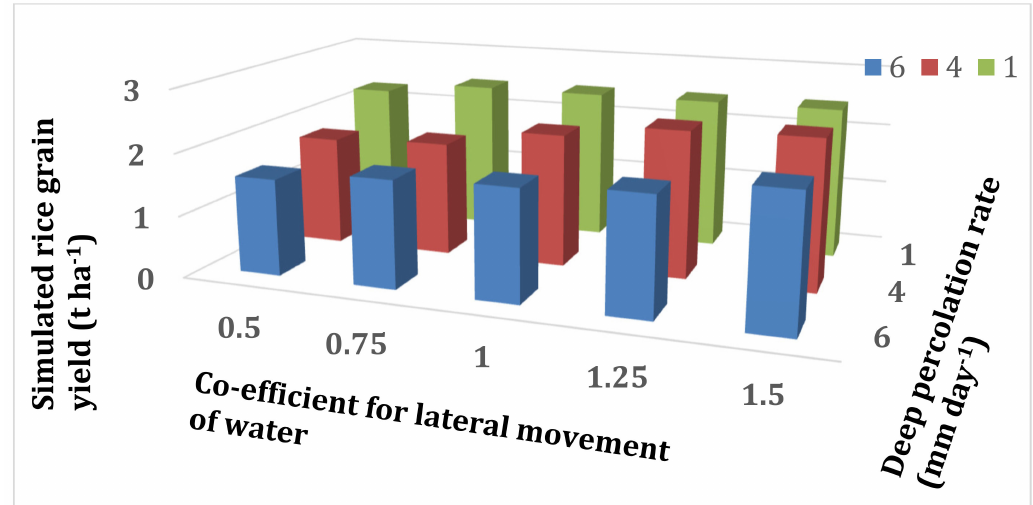
Figure 6. Simulated grain yield (t ha -1 ) for rice cv. KDML105 under different degrees of lateral movement of water (C L ) and deep percolation rates (mm day -1 ) at Ubon Ratchatani, NE Thailand. [65]. C L < 1 indicates net runoff, C L = 0 indicates no lateral water flows and C L > 1 indicates net run-on of